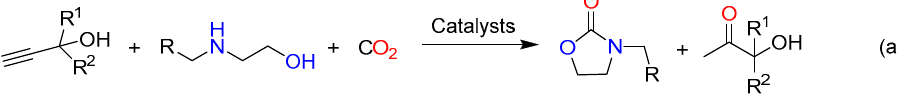
Table 2. One-pot three-component reactions of propargylic alcohols, CO 2 and 2-aminoethanols. Catalyst (Catalytic